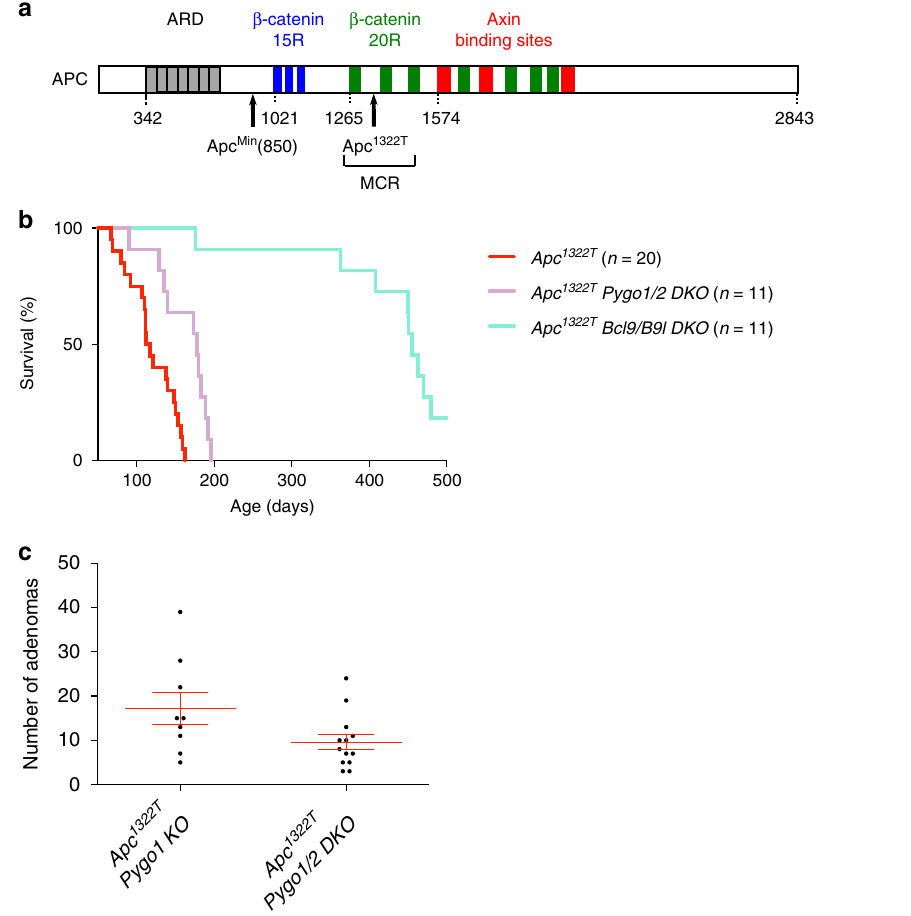
Fig. 6 Loss of Bcl9 suppresses the neoplastic disease of Apc 1332T mice. a Cartoon of human APC, with Axin ( red ) and β -catenin binding sites (15R1-3, blue ; 20R1-7, green ) in its central portion downstream of the ARD ( grey ); numbers , N-terminal limits of motifs; arrows , truncation endpoints of Apc Min and Apc 1332T alleles; bracket , mutation cluster region (MCR) in human colorectal cancers (see text). b Kaplan – Meier survival plots of Apc 1332T cohorts, as in Fig. 1a; statistical signi fi cance, p < 0.0001 (log-rank test). c Adenoma counts in small intestines from 77 day-old Apc 1332T Pygo1/2 DKO and matched Apc 1332T Pygo1 KO controls, as in Fig. 1b; statistical signi fi cance, p < 0.05 ( t- test). See also Supplementary Figures 9 &